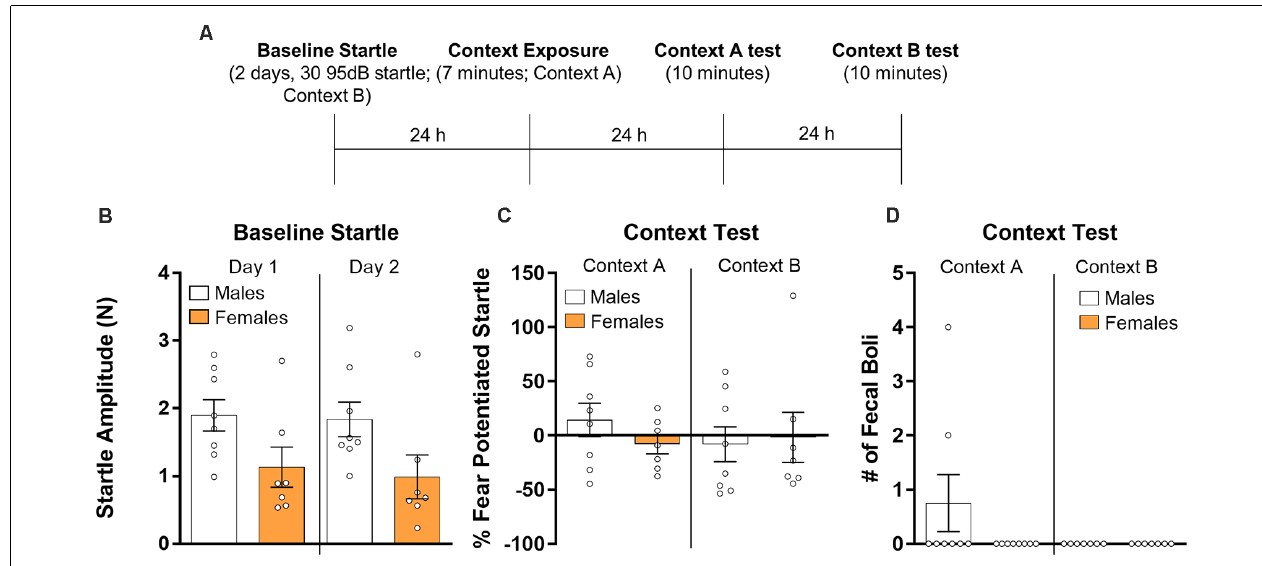
FIGURE 3 | Male ( n = 8) and female ( n = 7) rats were given baseline startle tests on consecutive days and the next day they were exposed to a fear conditioning chamber with no shock presented. Rats were then exposed to the training context (Context A) and the next day re-exposed to the startle context (Context B) for 10 min during which fear-potentiated startle was assessed (panel A depicts the timeline of the experiment). (B) Average baseline startle amplitude in males and females during both days of startle testing. (C) Fear potentiated startle in the training context (Context A, right panel) and during a test in the startle chamber (Context B, left panel). (D) The number of fecal boli in males and females during the respective test